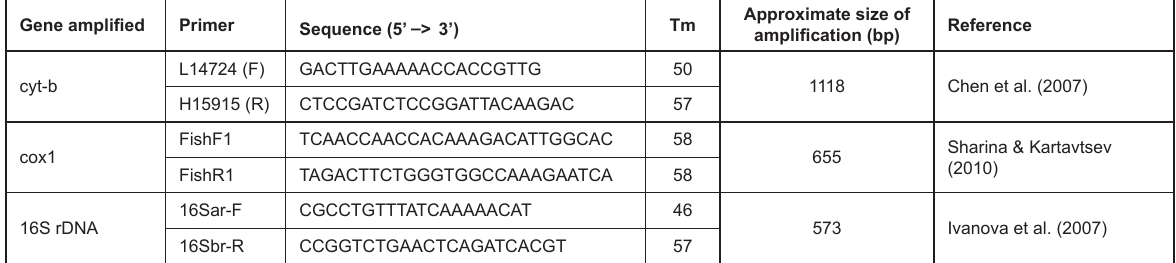
Table 1. Primer sequences used in this study Gene amplified